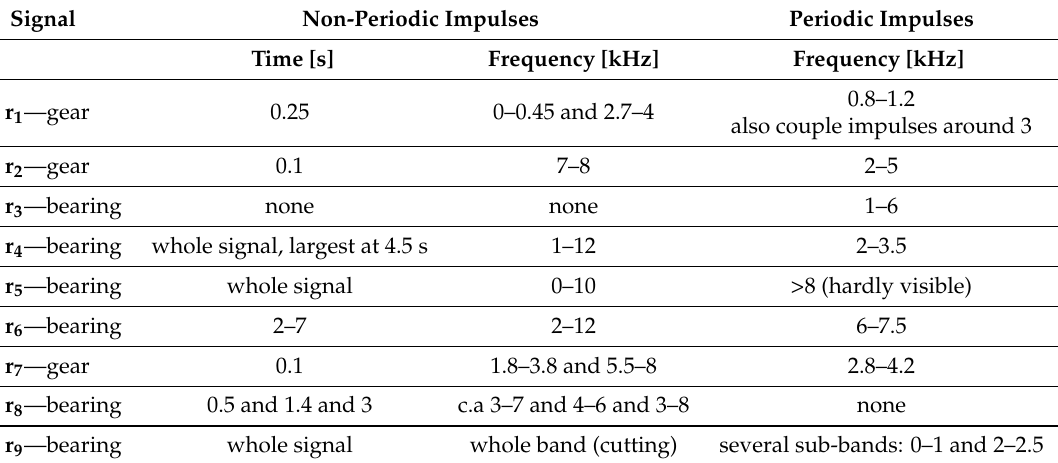
Table 2. The frequency ranges of cyclic and non-cyclic impulses for real signals. Signal Non-Periodic